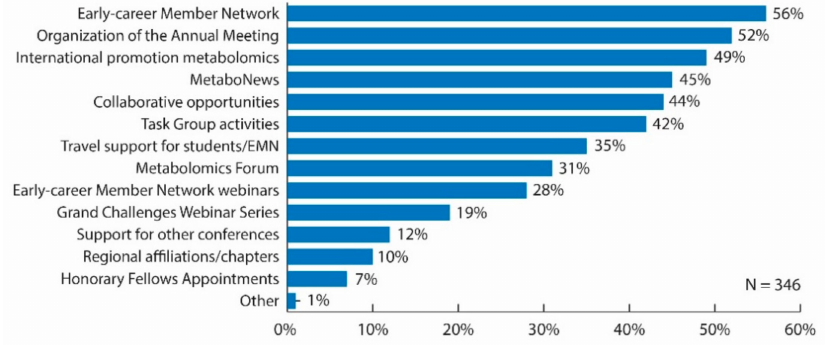
Figure 3. Bar graph of survey results for question: “What do you believe are the most important initiatives / activities that are currently supported by Metabolomics Society? Choose all that apply.” Original data used to create the figure can be found in the supplementary information under question number